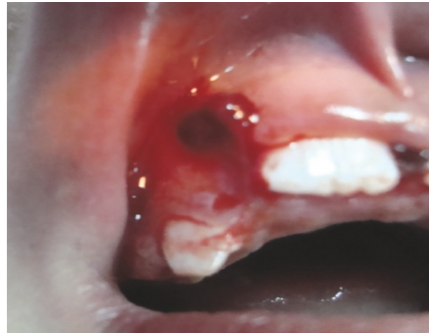
Figure 5: Final view after 8 hours of treatment. Bleeding was finally